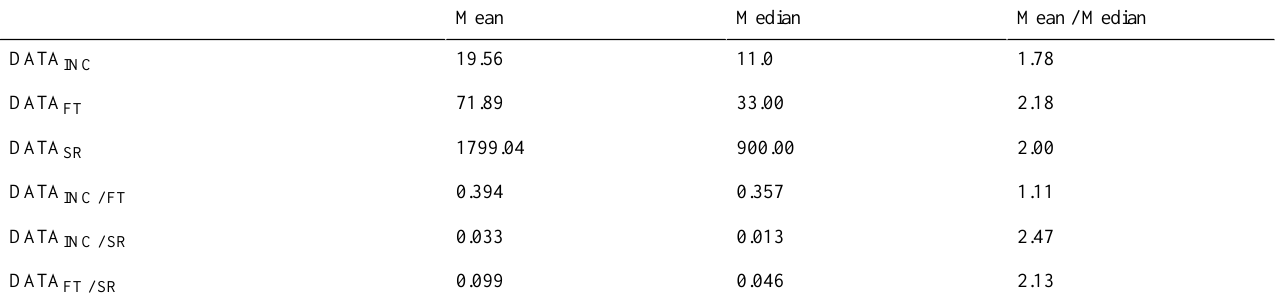
Table 4. Ratio between mean and median for collected treatment